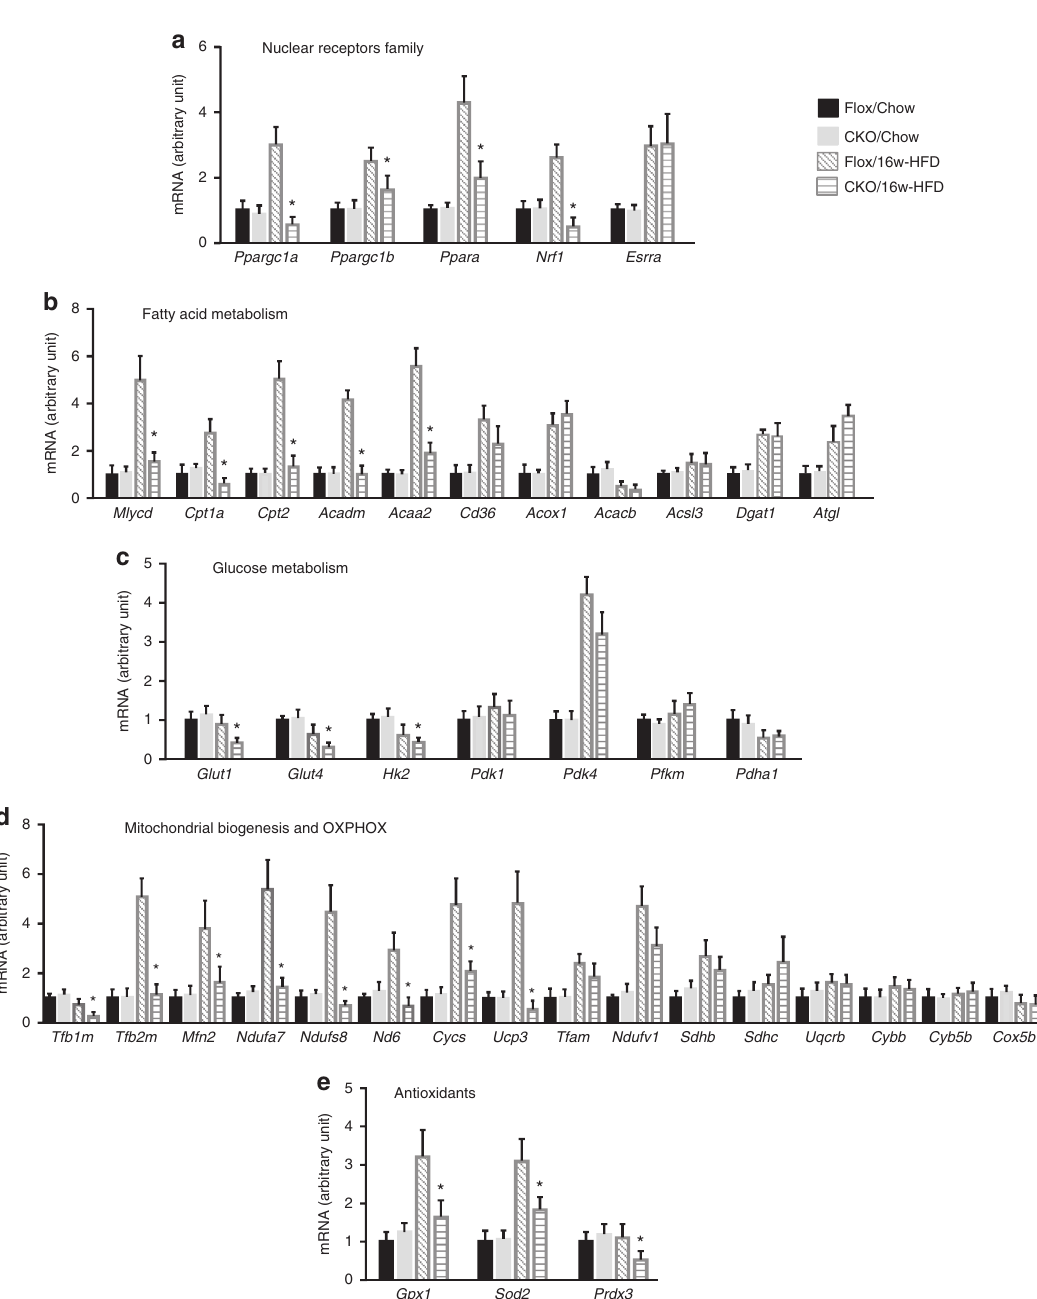
Fig. 5 Erk5 was required for mitochondrial function-related gene expression programmes. a Quantitative real-time PCR (qPCR) showed a decreased expression of Ppargc1a , Ppargc1b , Ppara , and Nrf1 in the hearts of HFD-CKO mice. The mRNA level of genes involved in FAO b , glycolytic action c , or mitochondrial biogenesis and OXPHOS d were assayed by qPCR. e The mRNA level of antioxidants was decreased in HFD-CKO hearts. Data are plotted as means ± SD (* P < 0.05, vs. HFD group, n = 7 mice per